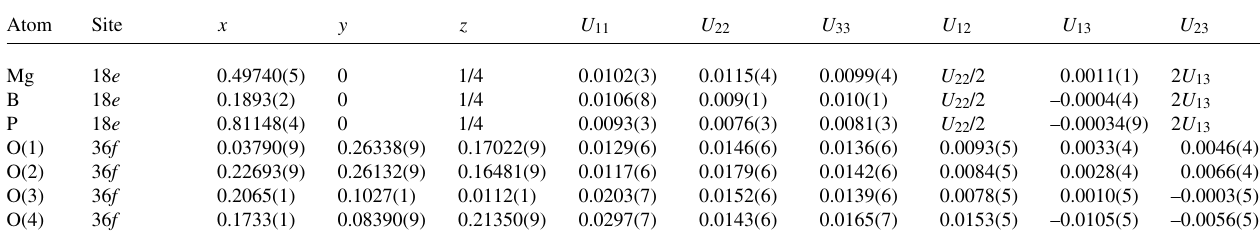
Table 3. Atomic coordinates and displacement parameters (in Å 2 )